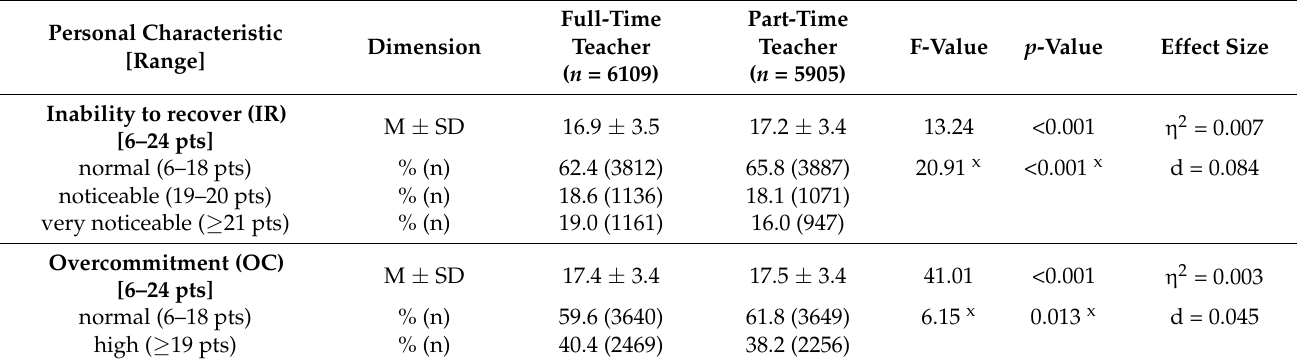
Table 5. Main effects of personal characteristics of full-time and part-time teachers.